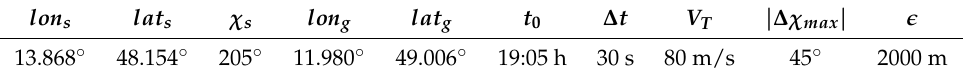
Table 21 lists the values used for the simulation of an automatic holding pattern. Table 21. Index s stands for start state and index g for the goal